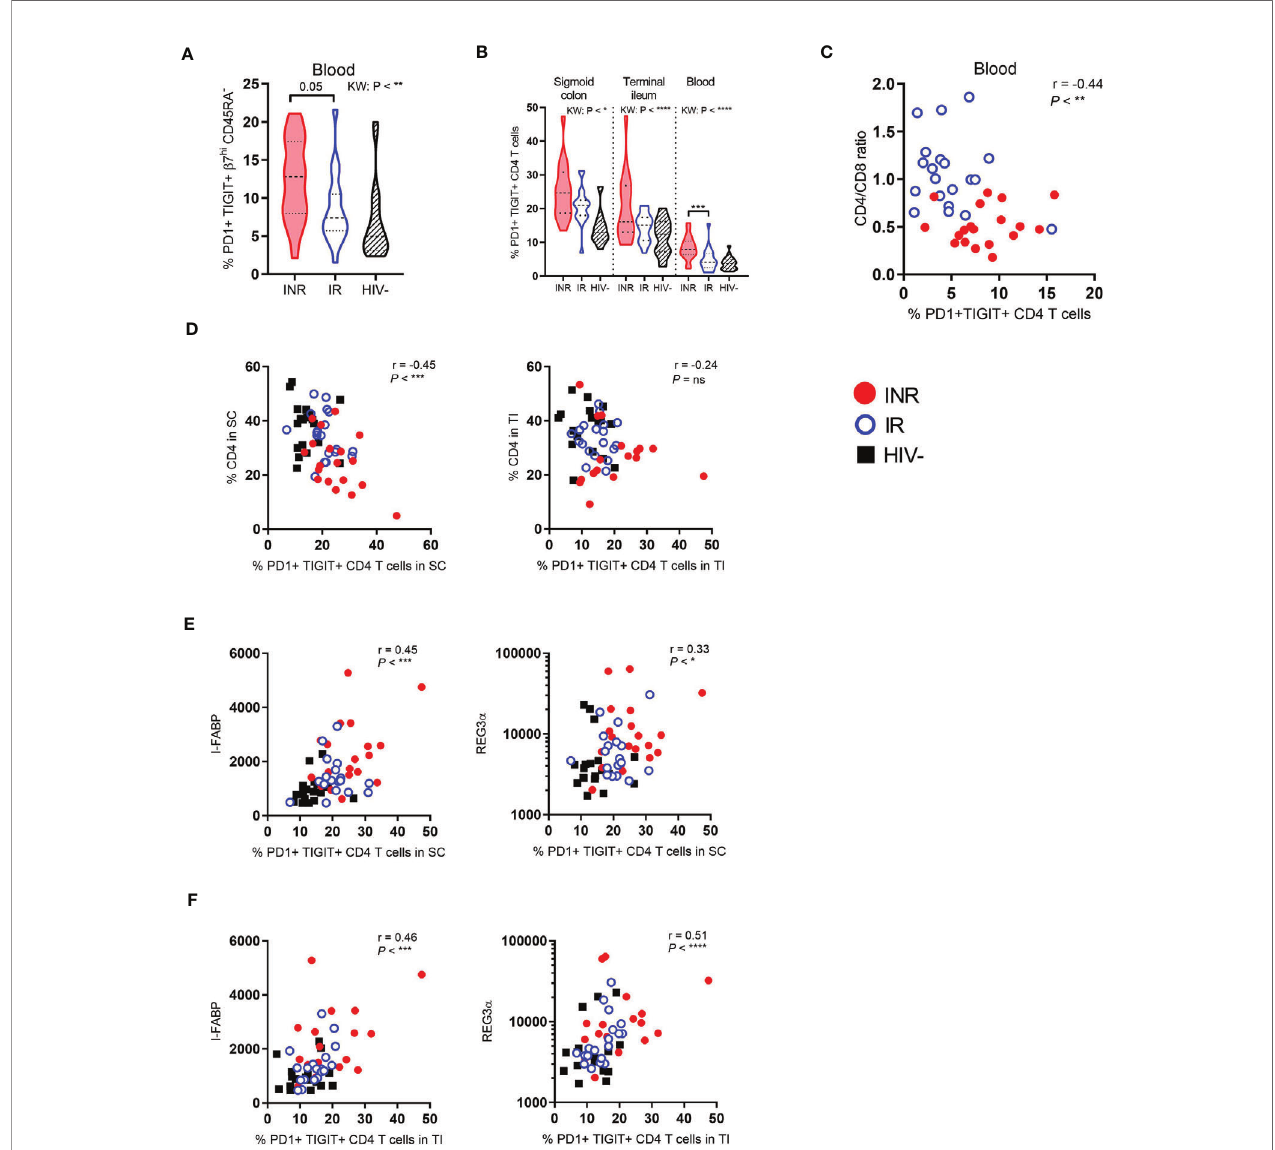
FIGURE 2 | INR have higher fractions of exhausted CD4 + T cells in both blood and gut which correlates with markers of enterocyte damage. PD1 and TIGIT expression analyzed by fl ow cytometry on gut-homing CD4 + T cells in blood (A) , and on the total CD4 + T cell population in both gut and blood (B) . (C) Correlation between the CD4:CD8 ratio and PD1 + TIGIT + CD4 + T cells in blood. (D) Correlation between the percentage of CD4 + T cells in sigmoid colon (left) or terminal ileum (right) and PD1 + TIGIT + CD4 + T cells in sigmoid colon or terminal ileum, respectively. (E, F) Correlation between I-FABP (left) or REG3 a (right) and the percentage of PD1 + TIGIT + CD4 + T cells in sigmoid colon (E) or terminal ileum (F) . INR indicated as red violin plots/dots, IR as open blue violin plots/circles, HIV negatives as lined black violin plots/black squares (dashed lines: median, dotted lines: quartiles). Statistical analyses were performed by Kruskal Wallis (KW) test with Dunn ’ s post-test between INR and IR and Spearman correlation. * P < 0.05, ** P < 0.01, *** P < 0.001, **** P < 0.0001, ns, not signi fi